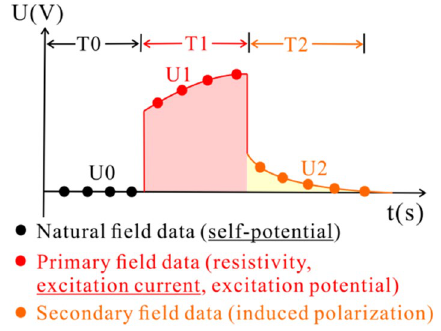
Figure 1. Potential time series of a single